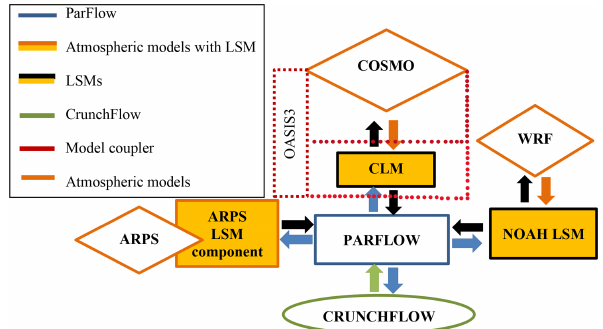
Figure 5. Schematic of the communication structure of the coupled models. Note: CLM represents the stand-alone Community Land Model. The modified version of the Common Land Model by Dai et al. (2003) is not shown here because it is a module only for ParFlow, not really a stand-alone LSM any